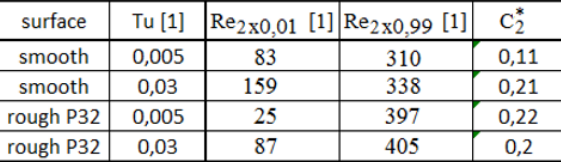
Table. 2. Measurement